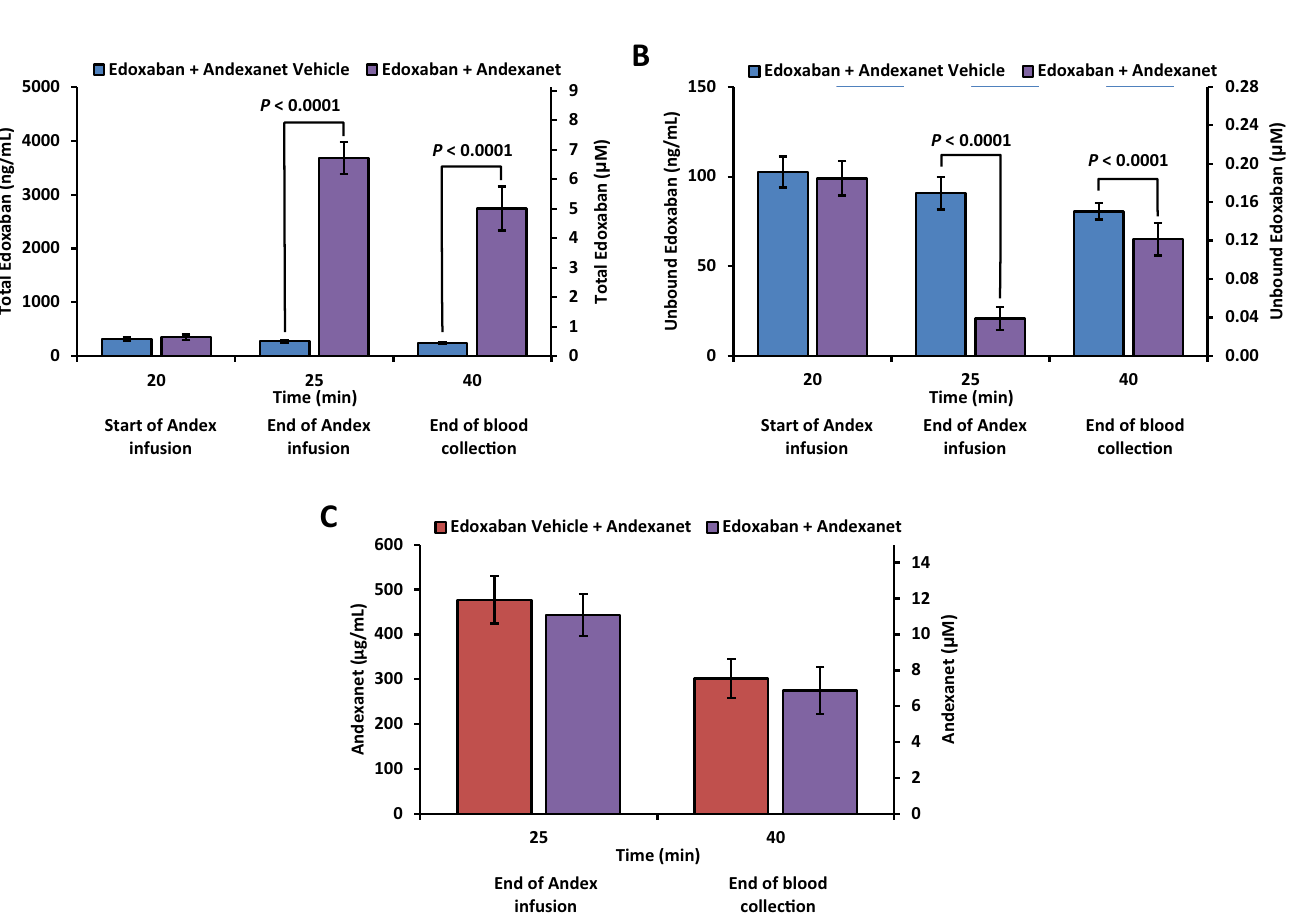
PLOS ONE | https://doi.org/10.1371/journal.pone.0195122 March 28,